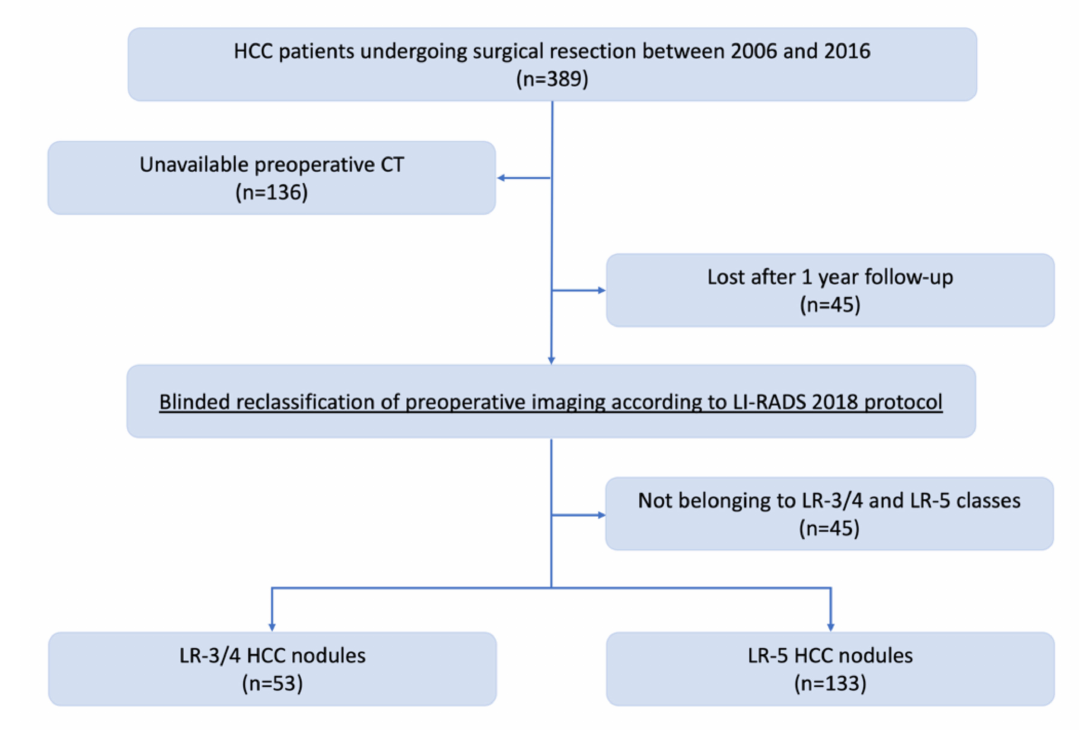
Figure 1. Flowchart for patient selection.